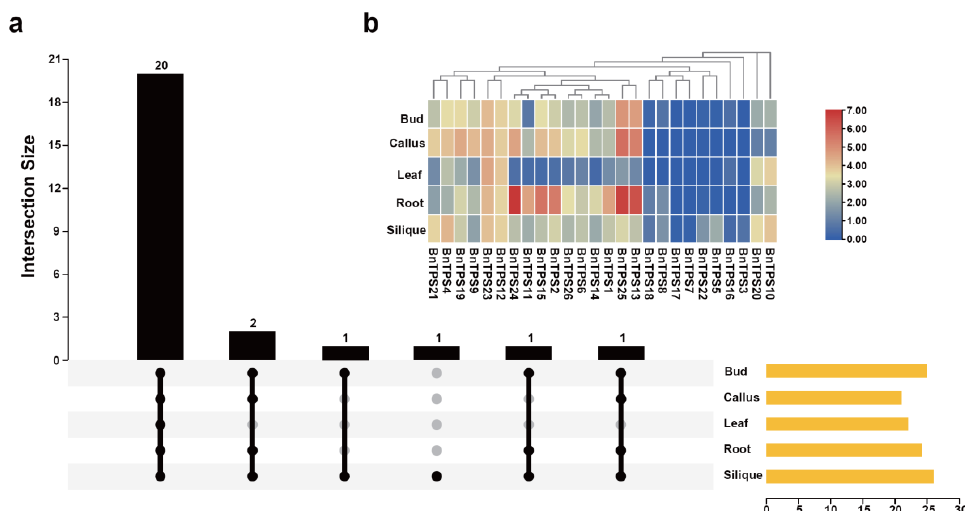
Figure 6. Expression profiles of BnTPS genes in five tissues. ( a ) The number of BnTPS genes that were expressed in five tissues. ( b ) Heatmap representation of 26 BnTPS genes in five tissues. Log2 normalization was used to process the expression data. From low (blue color) to high (red color), the color scale represents relative expression levels.